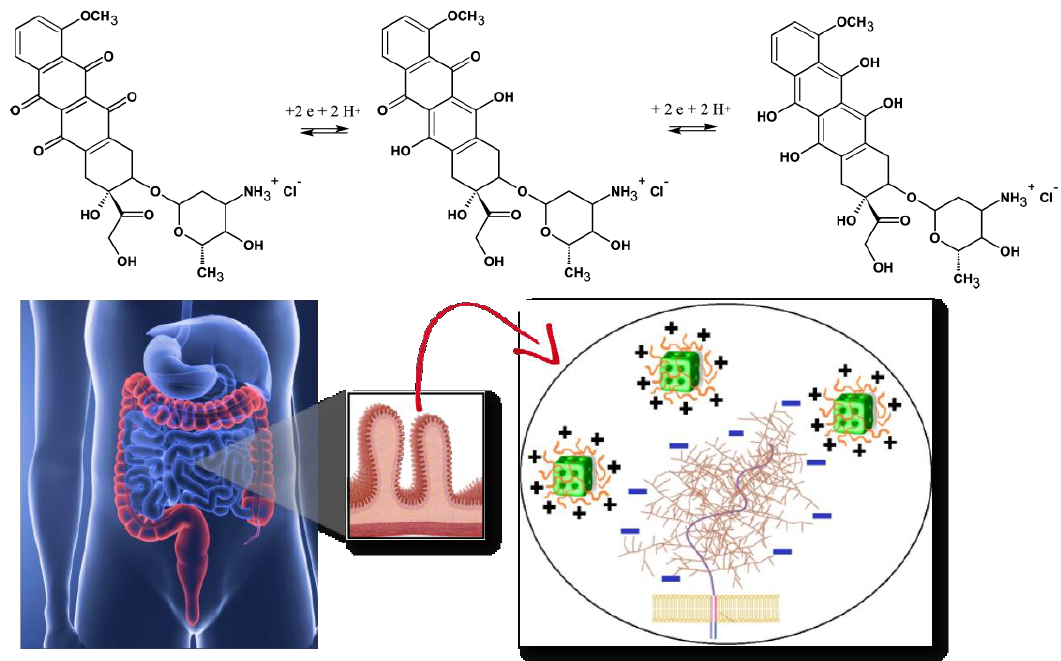
Figure 2. Chemical structures and redox process of the anticancer drug doxorubicin, from left to right: initial, oxidized and reduced forms of doxorubicin (top panel). Scheme of oral drug administration indicating the microvilli of the intestinal membrane, for which bioadhesive positively charged cubosome particles (modified by polyelectrolyte shells) interact with the negative charges of the mucin layer over the mucosal membrane (bottom panel). Either the biocompatible polyelectrolyte shells or the lipids, constituting the cubosome nanocarriers, are pH-sensitive.